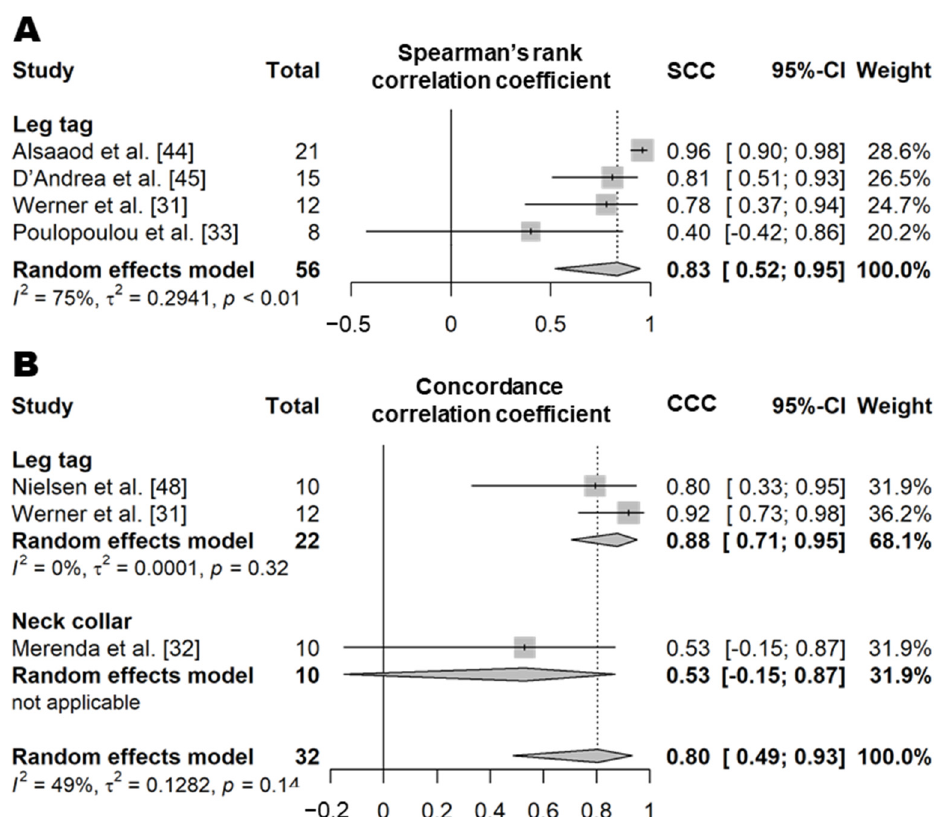
Figure 8. Forest plot of the correlation coefficient of walking time between wearable sensors and visual observation. ( A , B ) show Spearman’s correlation coefficient and concordance correlation coefficient, respectively. ‘Total’ means the sample size of each study and ‘Weight’ means the weight for the mean based on the sample size.